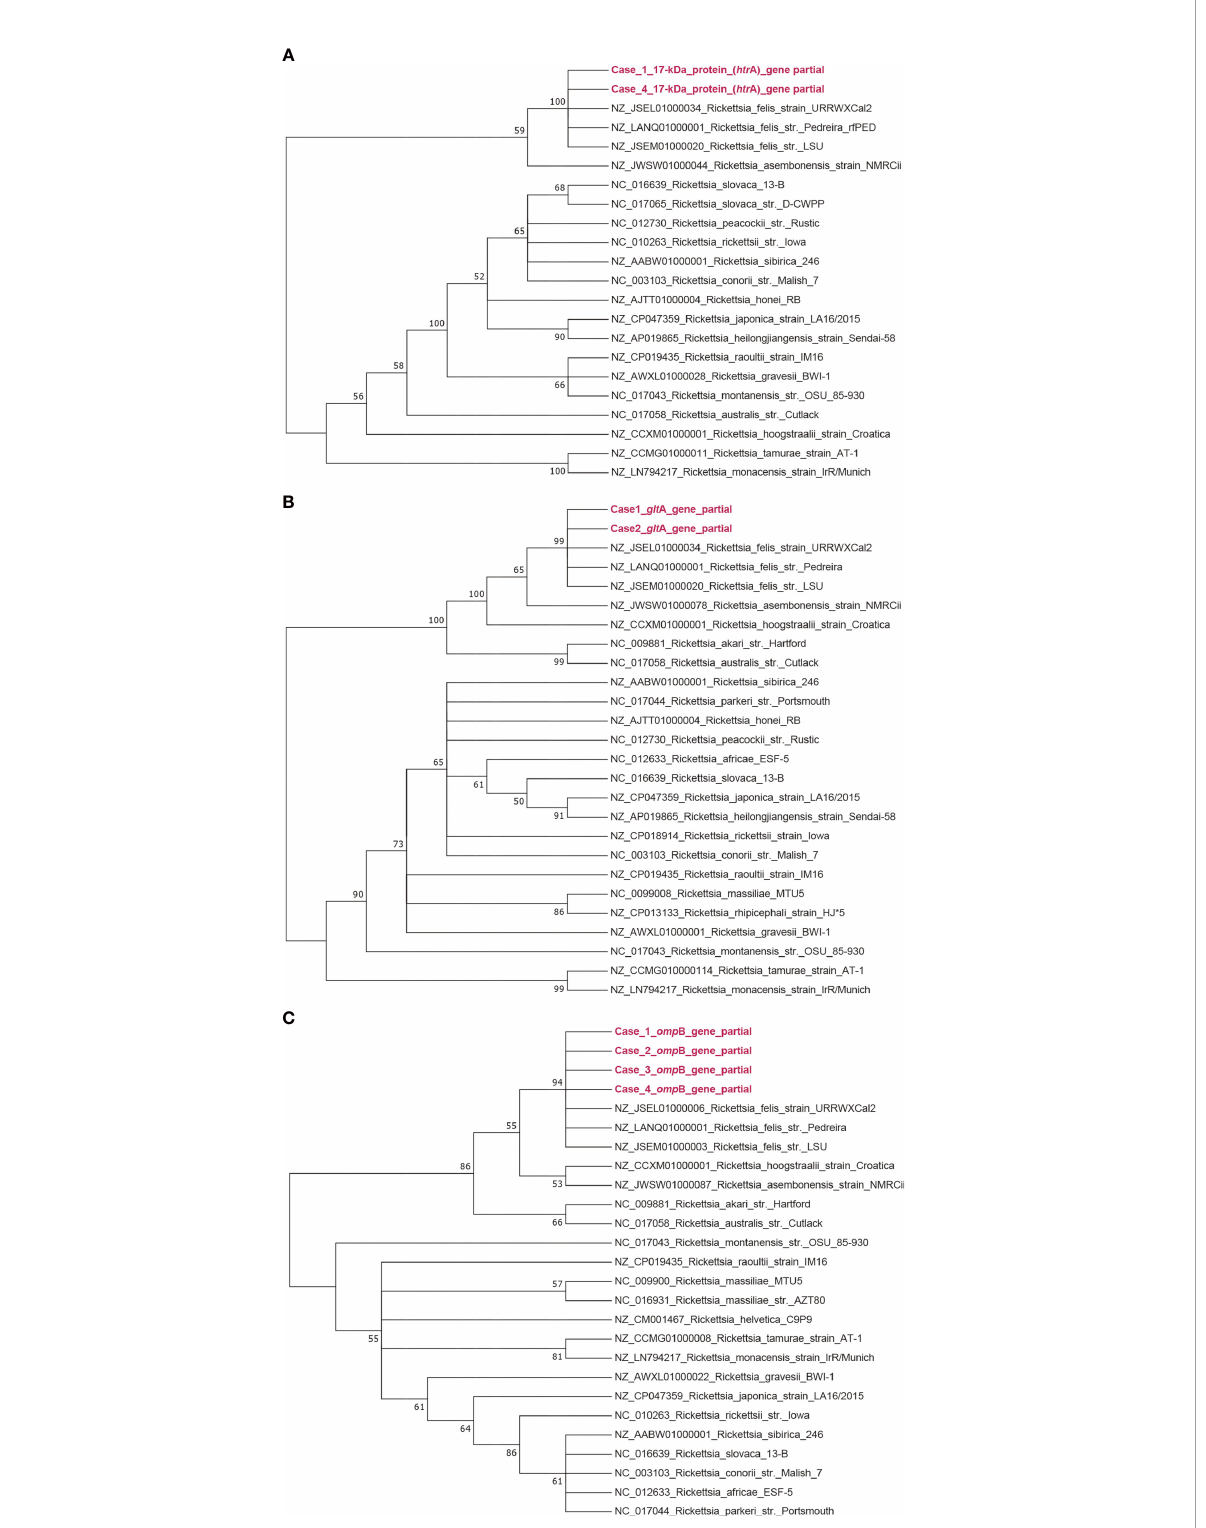
FIGURE 2 Phylogenetic analysis of Rickettsia spp. obtained from this study. Bootstrap consensus phylogenetic tree constructed based on partial sequences of glt A (A) , omp B (B) , and 17-kD (C) by the neighbor-joining method with 1000 bootstrap